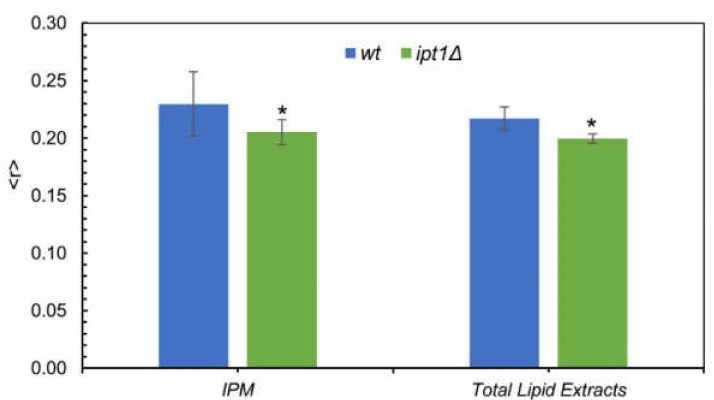
Figure 2. The global order of the plasma membrane of S. cerevisiae is higher in wt than in ipt1 ∆ cells. The diphenylhexatriene (DPH) steady-state fluorescence anisotropy at 24 ◦ C was obtained as described under “experimental procedures” for wt and ipt1 ∆ cells isolated plasma membrane (IPM) and multilamellar vesicles (MLVs) made from total lipid extracts obtained from cells in mid-exponential phase. The values are the mean ± S.D. of at least four biological replicates. * p ≤